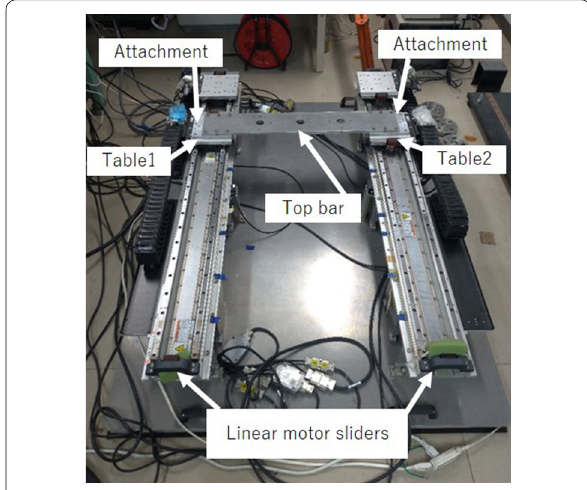
Fig. 1 Gantry-type linear motor slider